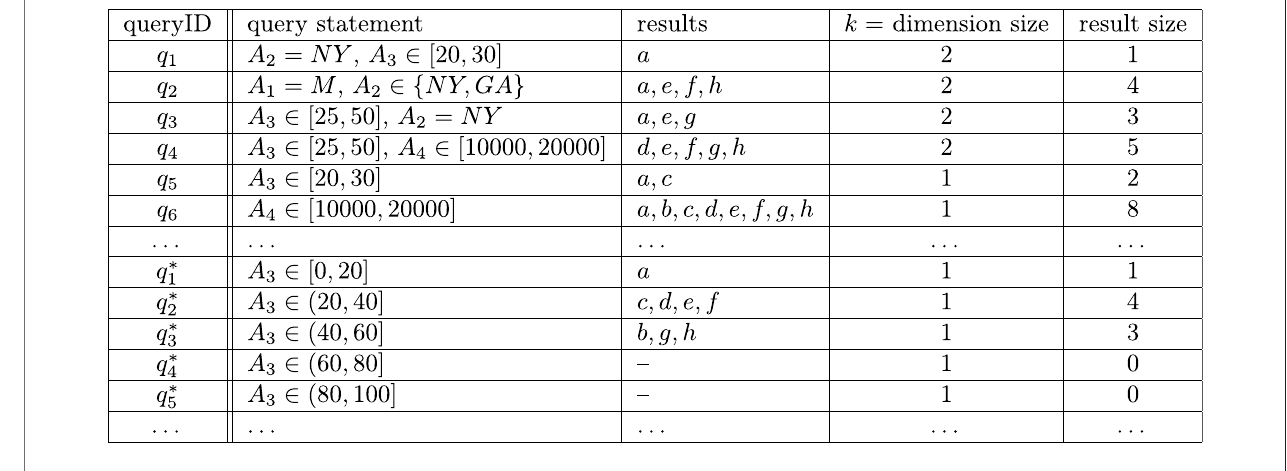
FIGURE 4 | Index structure resultPool of